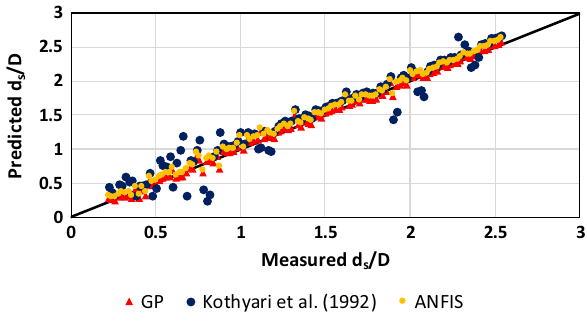
Fig. 8 ANFIS- and GP-predicted values of d (1992) values